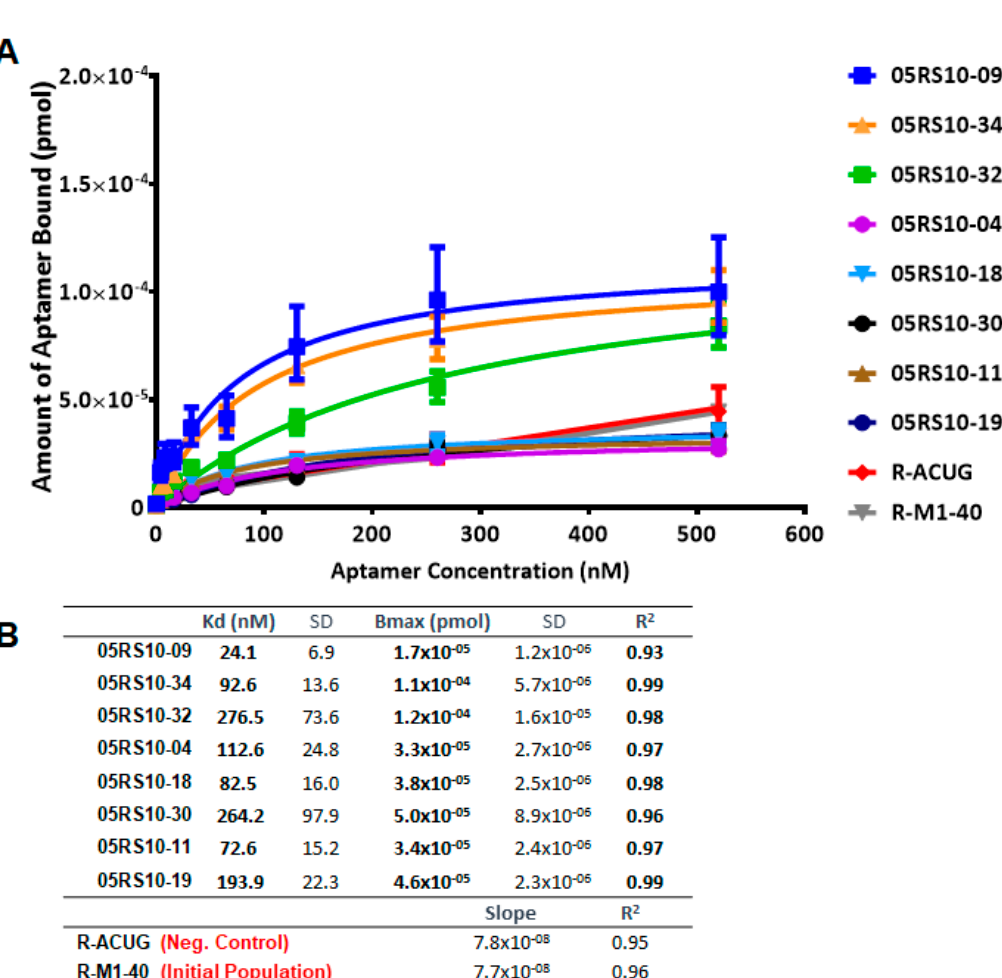
Figure 6. Characterization of the high affinity RNA individual aptamers present in the last SELEX round, using ELONA-RTqPCR. Affinity curves ( A ) and derived Kd and Bmax values ( B ) of eight selected RNA aptamers and their corresponding controls (R-ACUG and R-M1-40, see text and Figure 5 legend for details). The upper limit of the y axis in panel A was chosen to be the same as that in Figure 5, to allow a direct comparison of the performance of ssDNA and RNA aptamers targeting PCBP-2.